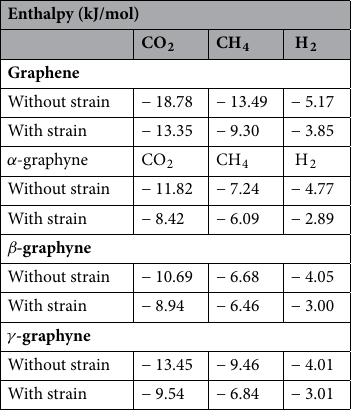
Table 3. Adsorption enthalpies at T = 298 K for CO 2 , CH 4 and at T = 77 K for H 2 on graphene and graphynes without and with strain.